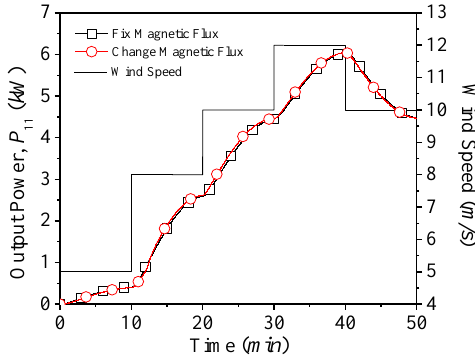
Figure 10. Output power variation at different wind speeds.